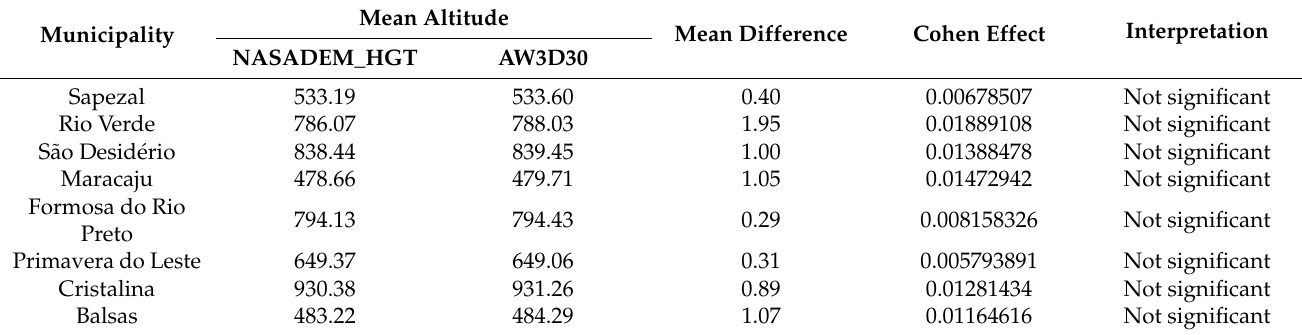
Table 12. Size measurements of the Cohen effect size per